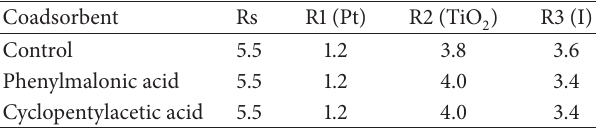
Table 3: Impedance parameters of DSC devices with PMA or